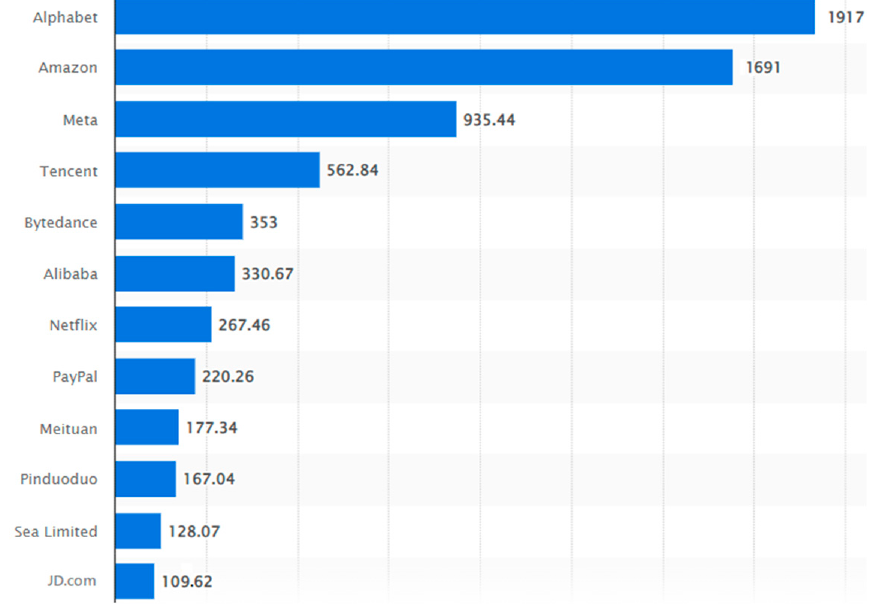
Figure 6. The market capitalization of the largest internet companies worldwide (June 2022). Source: [66].